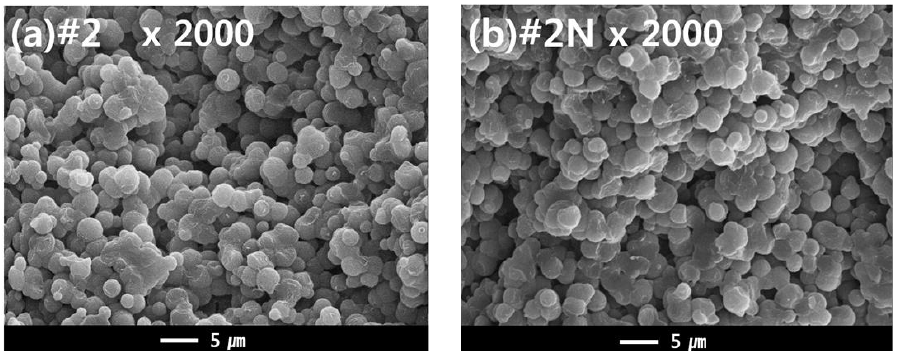
Figure 9. SEM images comparing the cross-sectional morphologies of dual-layer PVDF membranes (1) without, and (2) with the nucleating agent. Hollow fiber spinning conditions: TIPS = 17 g/min, NIPS = 7 g/min, Bore = 6 g/min. ( a ) Cross sectional image of Sample #2 at ×2000, and ( b ) Cross sectional morphology of sample #2N (nucleated) at ×2000.